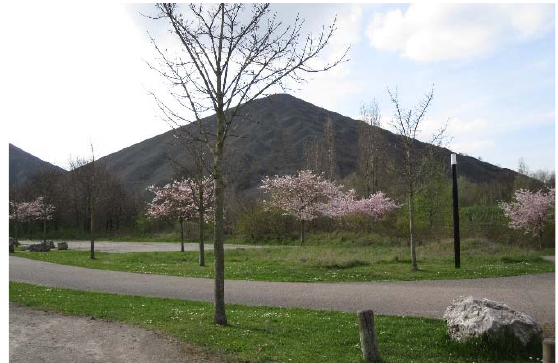
Figure 1. Traces of mining in the landscape, Lens, France.